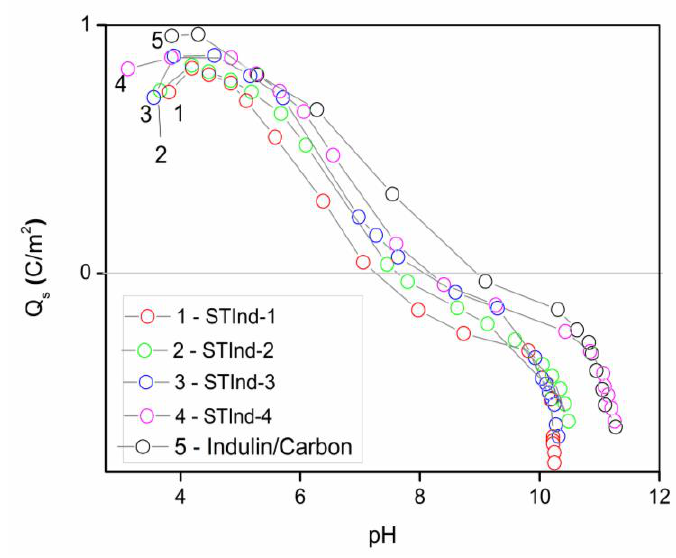
Figure 4. Surface charge density as a function of pH (Qs vs. pH) of carbonized indulin-based bio-chars.